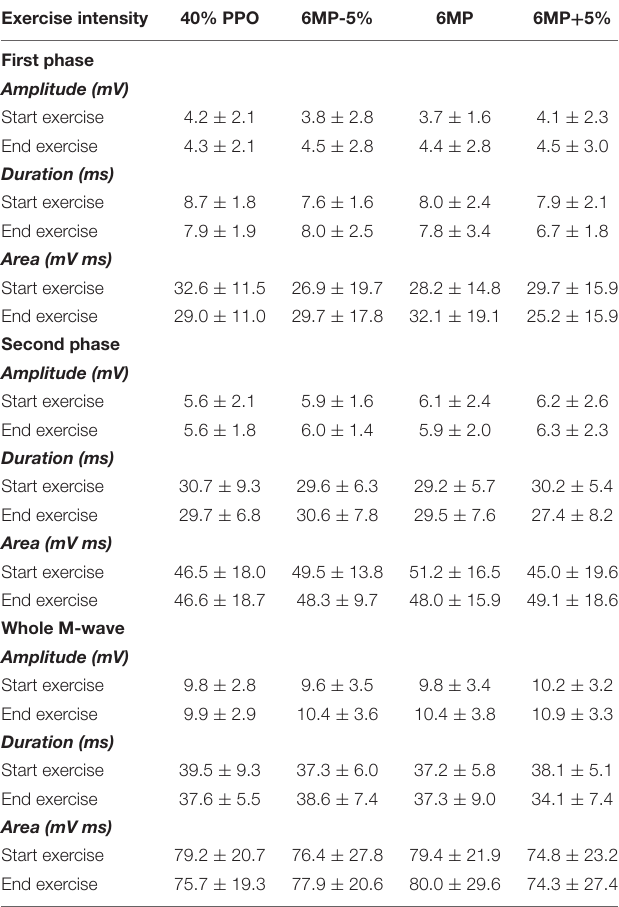
TABLE 2 | Effects of dynamic exercise intensity on M-wave